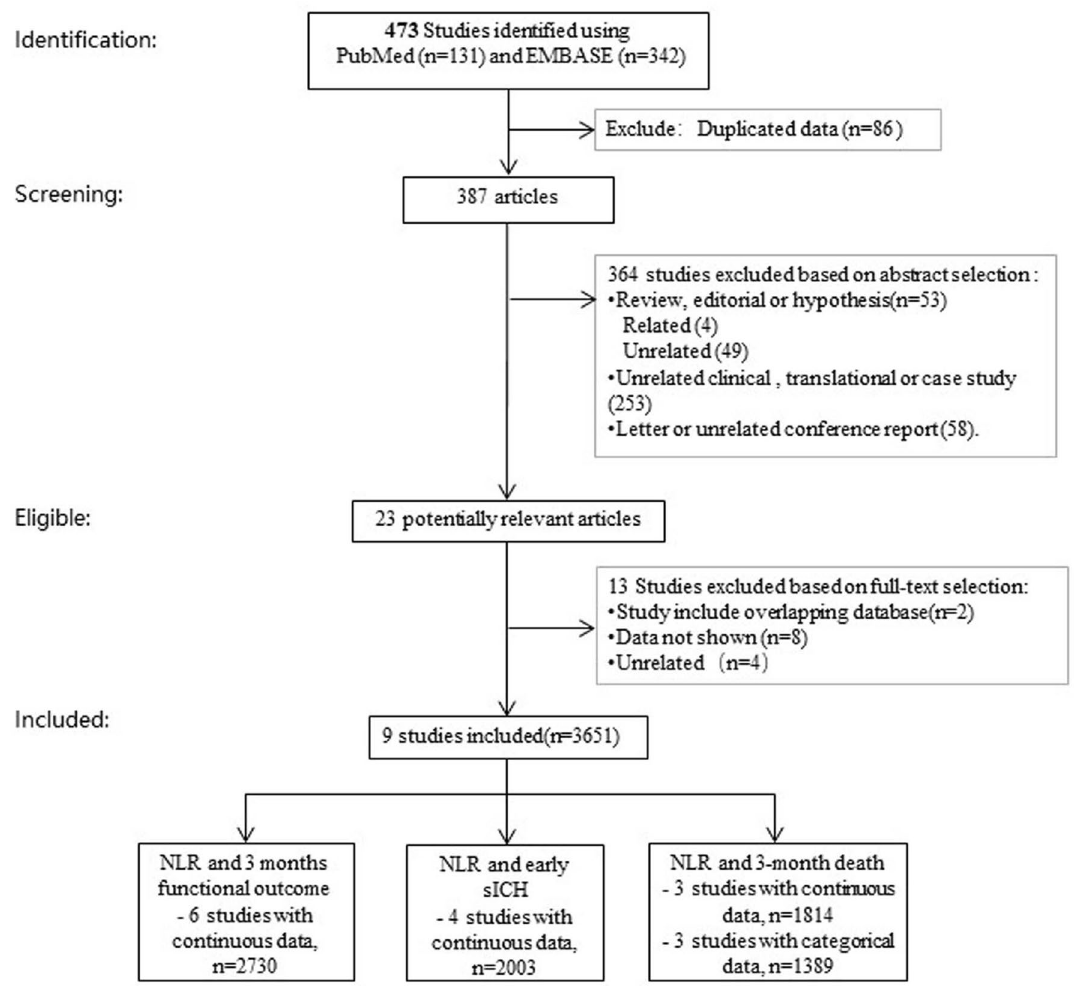
Figure 1. Flow chart of literature search and study selection. NLR neutrophil to lymphocyte ratio, ICH intracranial